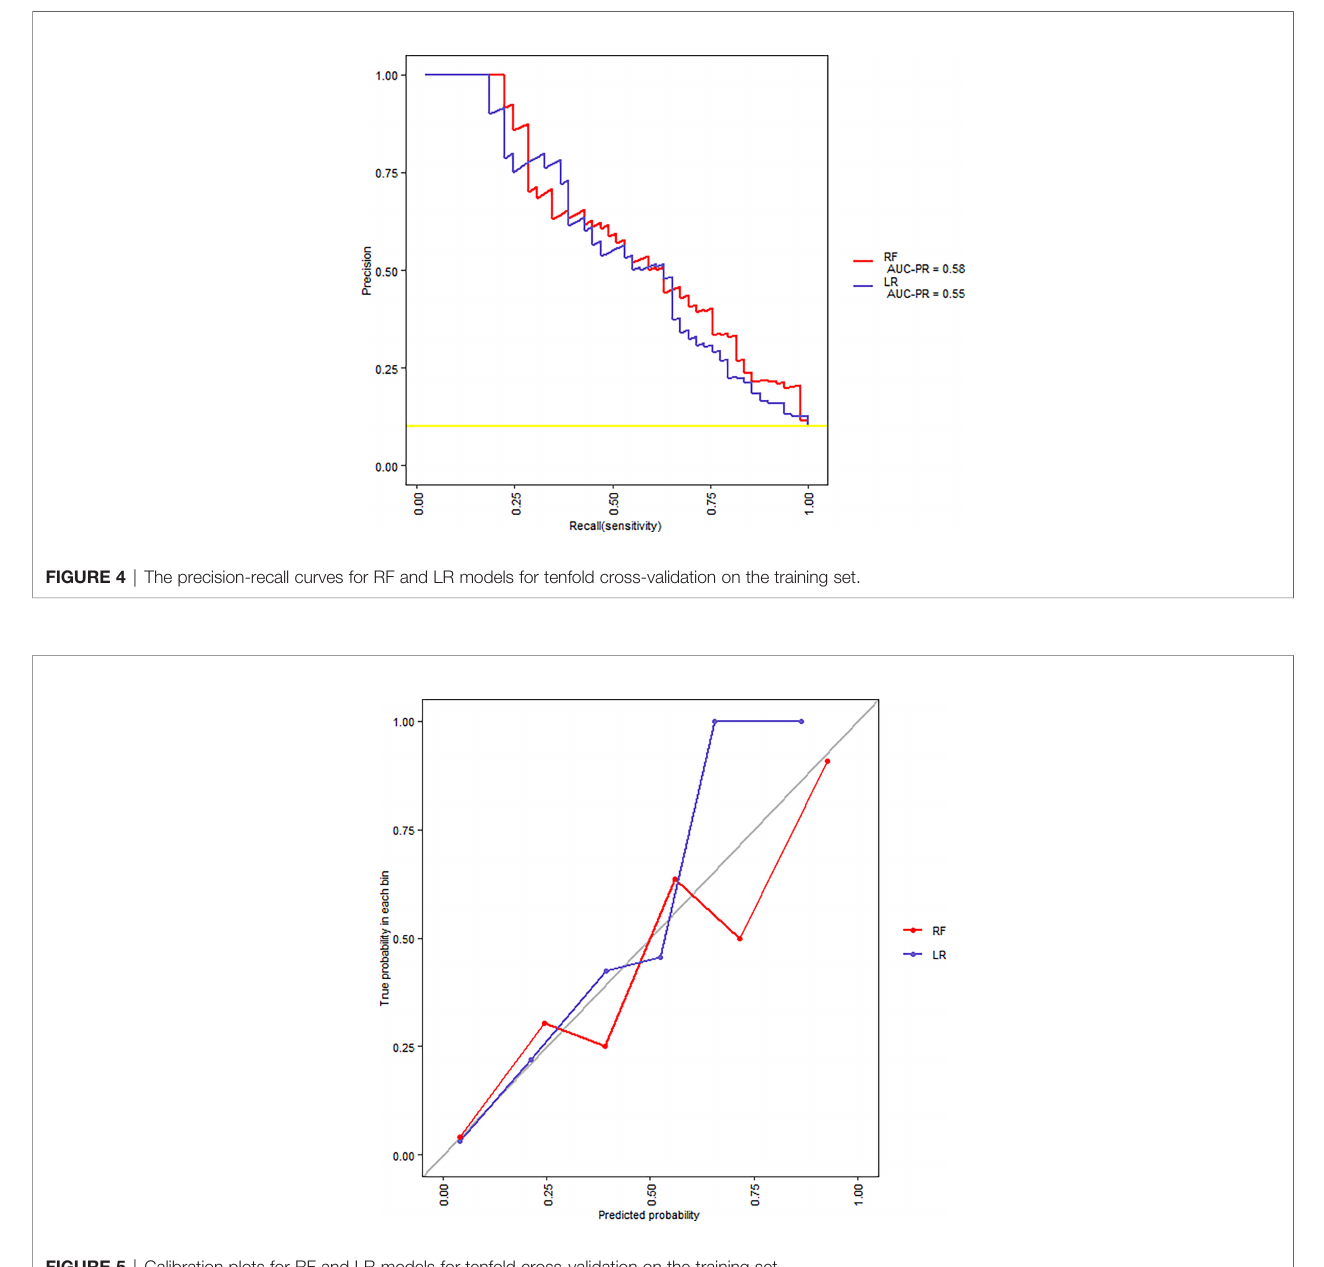
FIGURE 5 | Calibration plots for RF and LR models for tenfold cross-validation on the training